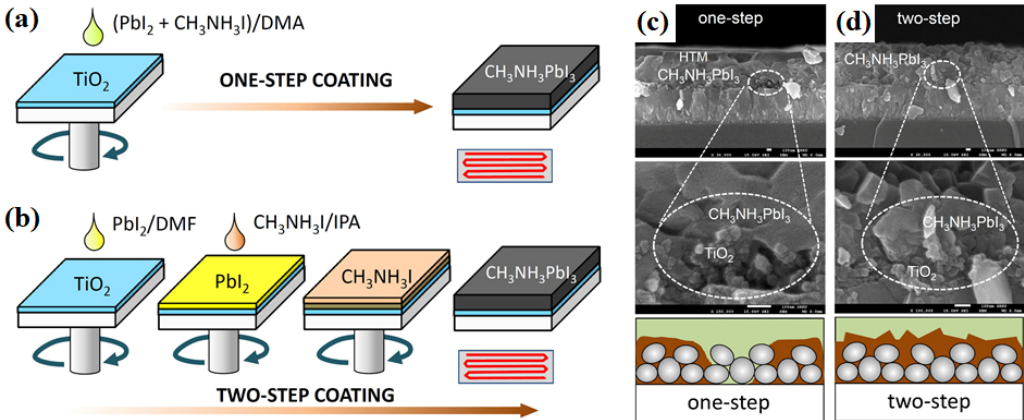
Figure 10. One- and two-step spin-coating procedures for CH 3 NH 3 PbI 3 formation and cross-sectional SEM images of ( a )